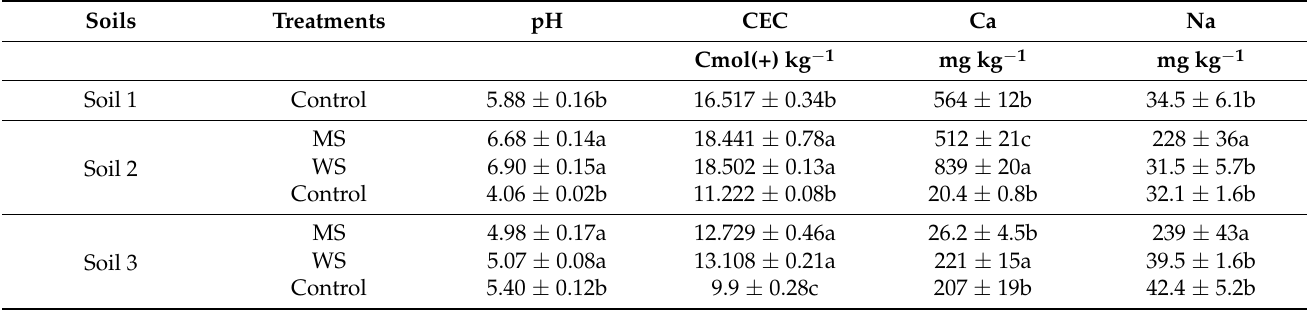
Table 2. Effects of adding 440 mg · kg − 1 Si on the pH values, CEC, and concentrations of available Ca and available Na of six soils. Soils